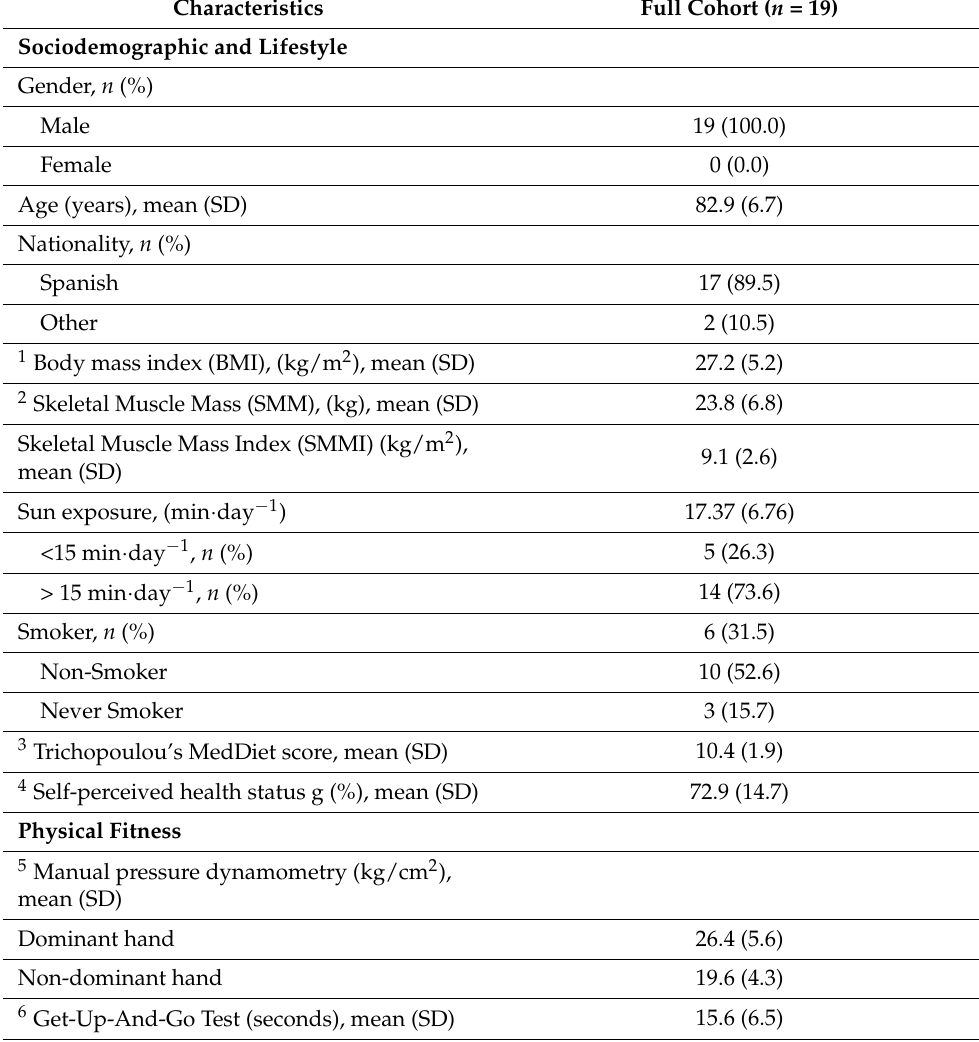
Table 1. Sociodemographic and Lifestyle, Physical Fitness, Clinical and Vital signs Characteristics- Related with study